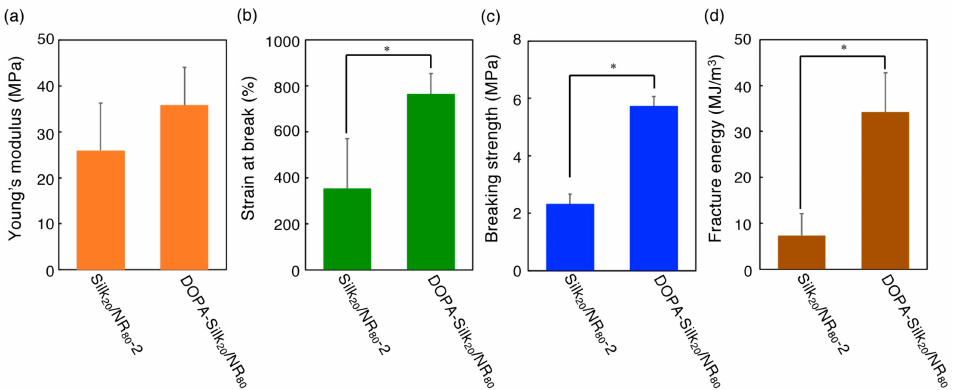
Figure 10. Mechanical properties of silk 20 / NR 80 -2 and DOPA-silk 20 / NR 80 : ( a ) Young’s modulus, ( b ) strain at break, ( c ) breaking strength, and ( d ) fracture energy. The silk content was fixed at 20 wt%. * Significant di ff erences between groups at p < 0.01.